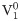
Graphical illustration of local versus global effects of value updating following covert comparisons.The initial values of item 1 to n are indicated as a V10 to Vn0 vector. Each item was presented several times during the choice task, each time paired with a different set of other items. After the first round, each item value is updated according to the covert pairwise comparison process (model H2.1), generating the V11 to Vn1 vector. Likewise, after the second round, the vector of item values is updated to V12 to Vn2. (A) The local model presumes that the updated values after covert comparisons are not stable and cannot carry over to subsequent trials. Thus, when a later trial presents the same item, its value has reversed back to the initial value (i.e., the likeability rating). (B) The global model assumes that the updated values are stable and thus can be passed on from one round to the next. The updated value from a previous trial can serve as a starting point for a new update in the next trial presenting the same item.